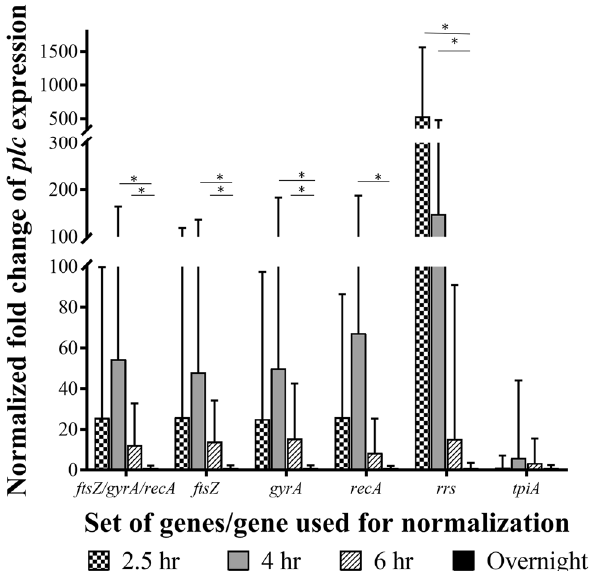
Figure 2. Relative expression of alpha toxin ( plc ) during growth of Clostridium perfringens over a 22-h period. The expression data were normalized using ftsZ , gyrA , recA , rrs , or tpiA as reference genes individually and with the geometric mean of ftsZ + gyrA + recA. 22-h samples were considered the control for calculations. P ≤ 0.05 shown by